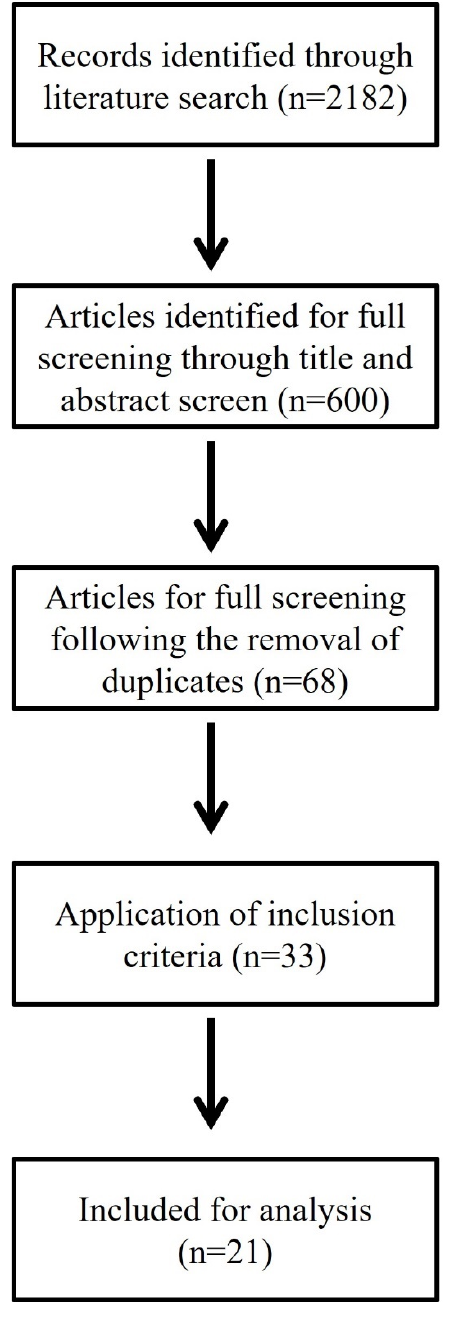
Figure 1. Study selection process.